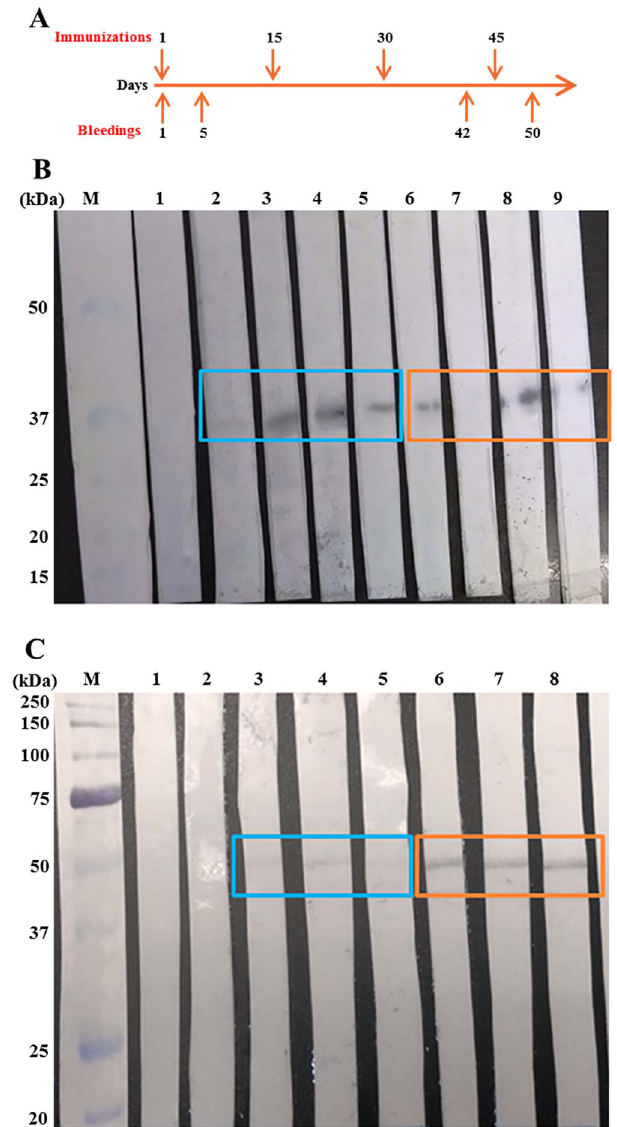
Figure 3. Immunological response in mice vaccinated with the recombinant antigens. A. Immunization and bleeding scheme. B. Immunoreactivity of rGluCl veri fi ed by Western blotting. Lane M: protein marker; Lane 1: pooled preimmune sera from 4 mice; Lanes 2 – 5: individual sera of bleeding 3 from 4 mice; Lanes 6 – 9: individual sera of bleeding 4 from 4 mice. Immunoreactive bands of ~35 kDa are indicated by rectangles. C. Immunoreactivity of rGlyR veri fi ed by Western blotting. Lane M: protein marker; Lane 1: pooled preimmune sera from 3 mice; Lane 2: pooled sera of bleeding 2 from 3 mice; Lanes 3 – 5: individual sera of bleeding 3 from 3 mice; Lanes 6 – 8: individual sera of bleeding 4 from 3 mice. Immunore- active bands of ~51 kDa are indicated by